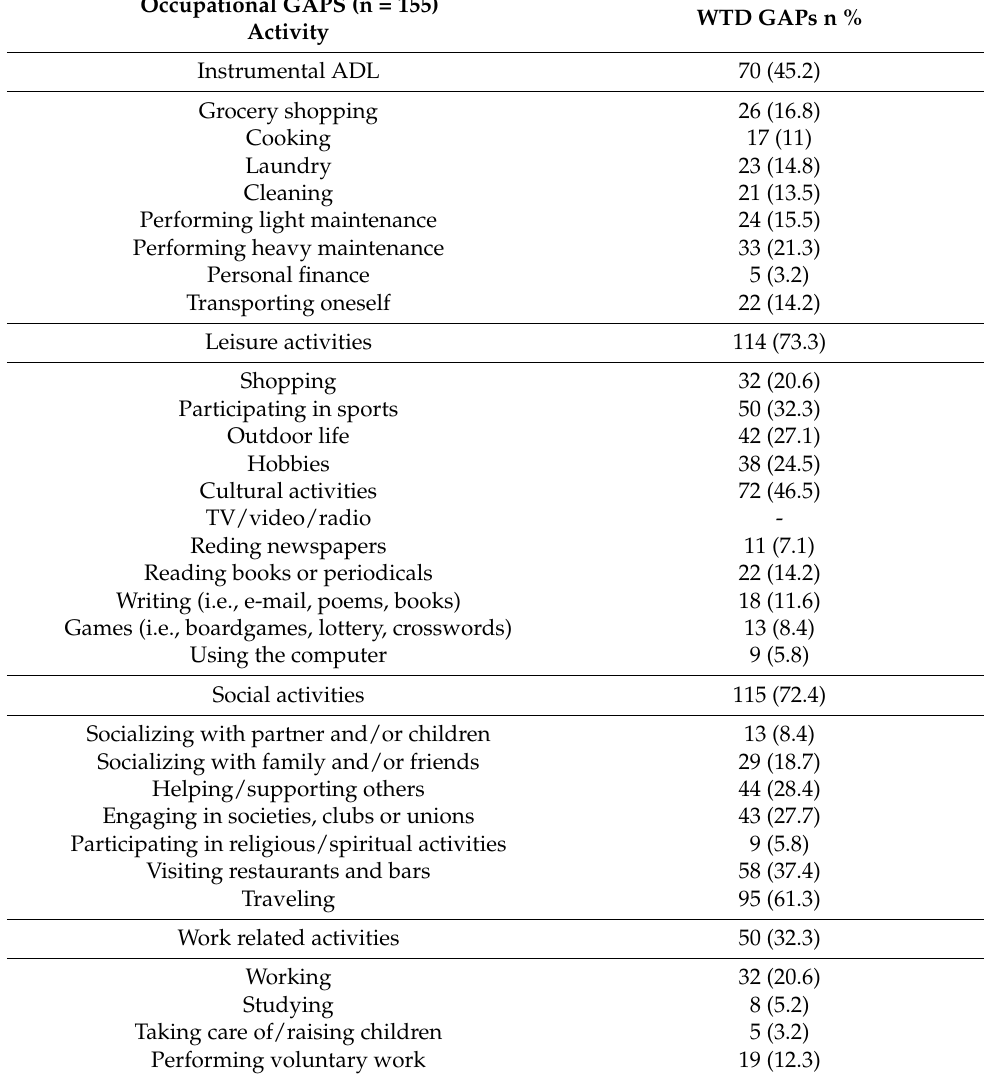
Table 3. Occupational GAPS. Abbreviations: n: count, ADL: activities of daily